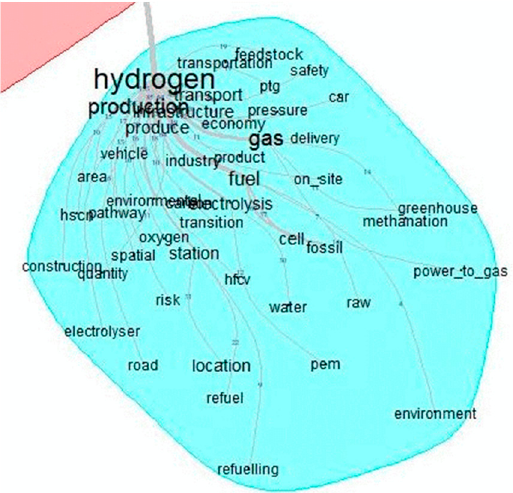
Figure 9. The set of words focused around the word “hydrogen” in the case of the analysis of inten- tionally selected words. Source: Own elaboration based on the analysis in the IRAMUTEQ software.